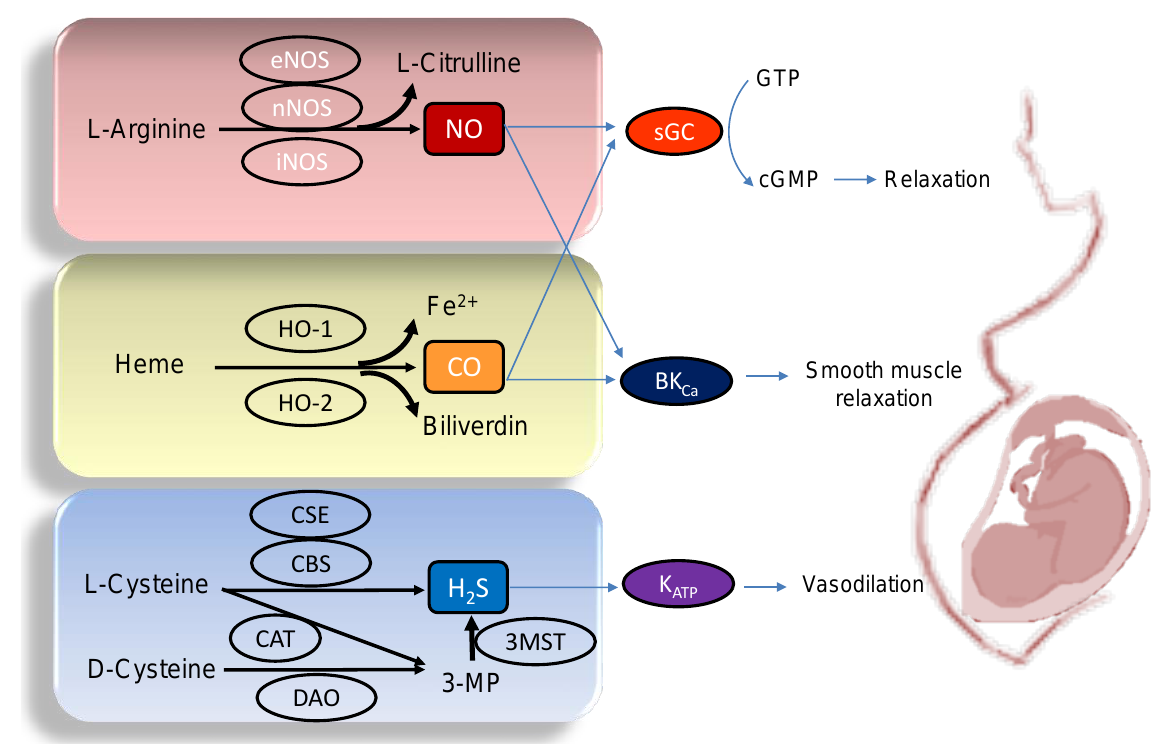
Figure 1. Schematic illustration of the enzymatic synthesis of NO, CO, and H 2 S and downstream signaling able to maintain maternal and feto-placental homeostasis. NO (upper panel) is formed by neuronal NOS (nNOS), endothelial NOS (eNOS), and inducible NOS (iNOS) from L-Arginine. Heme oxygenase-1 (HO-1) and -2 (HO-2) enzymes degrade heme to generate CO, iron, and biliverdin (middle panel). Three enzymes have been identified to enzymatically generate H 2 S (Lower panel), cystathionine β -synthase (CBS), cystathionine γ -lyase (CSE), and 3-mercaptopyruvate sulphurtransferase (3MST). CBS and CSE produce H 2 S using L-cysteine. In an alternative pathway, 3-mercaptopyruvate (3-MP), the substrate for 3MST to produce H 2 S, is provided by cysteine aminotransferase (CAT) using L-Cysteine and D-amino acid oxidase (DAO) using D-Cysteine, respectively. The blue arrow lines indicate downstream signals of gasotransmitters in the maintenance of homeostasis in pregnancy. NO and CO both can activate soluble guanylate cyclase (sGC) to increase cGMP, resulting in smooth muscle relaxation. The large-conductance Ca 2+ -activated K + channel (BK Ca ) can also be regulated by NO and CO to elicit vasodilatation. Additionally, through the activation of ATP-sensitive K + -channels (K ATP ), H 2 S can cause vasodilation in pregnancy.